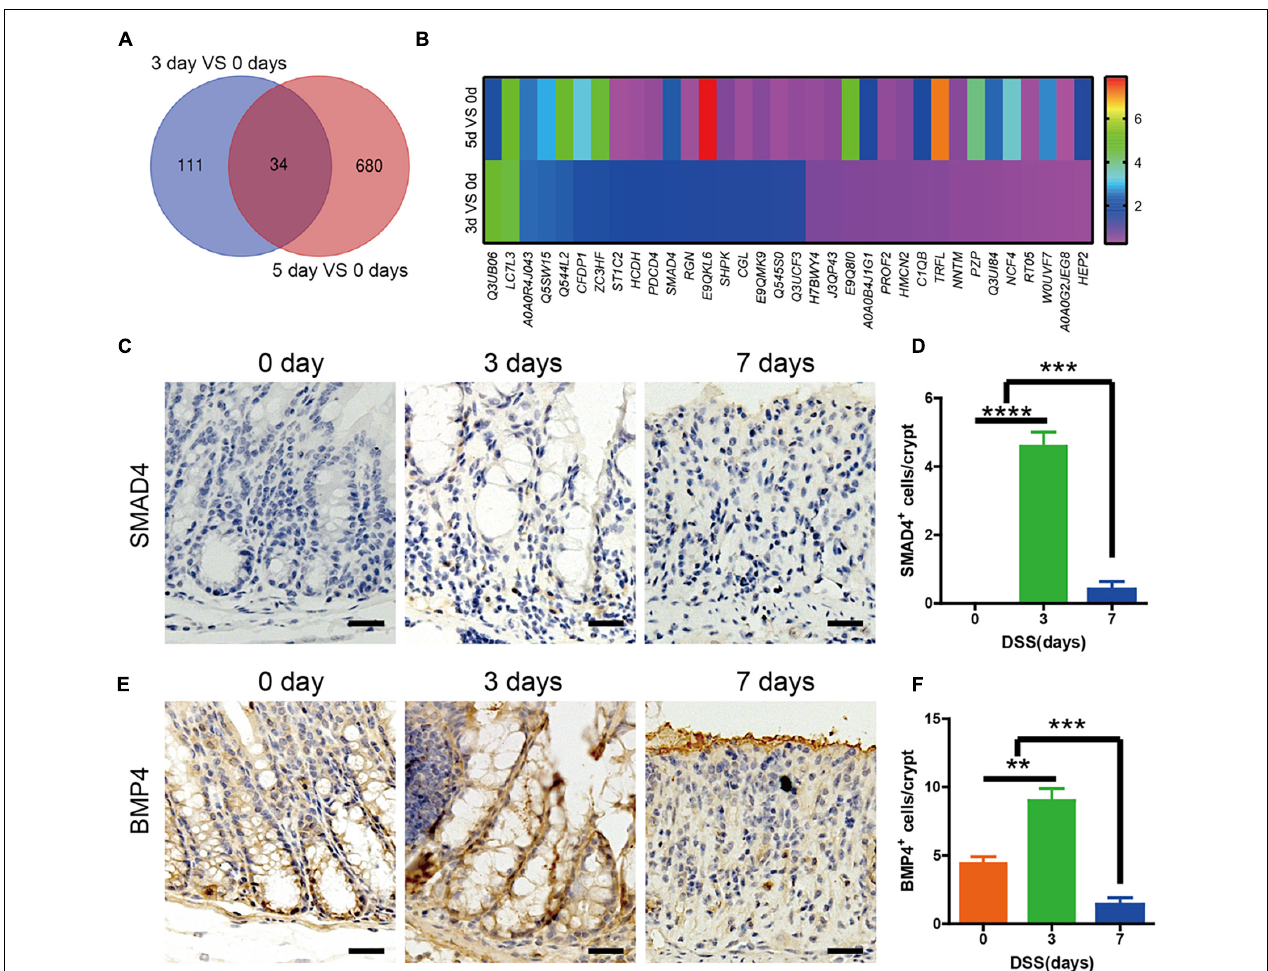
FIGURE 3 | SMAD4 and bone morphogenetic protein 4 (BMP4) expression in the colon of DSS-induced colitis mice. (A) Venn diagram showing the overlap colon protein between DSS-induced colitis on day 3 compared with day 0 and day 5 compared with day 0 ( n = 3). (B) Heatmap showing the expression levels of overlap colon protein between DSS-induced colitis on day 3 compared with day 0 and day 5 compared with day 0. (C) Immunohistochemistry staining of SMAD4 expression in DSS mice colon at days 0, 3, and 7. (D) Quantification of SMAD4-positive cells per crypt ( n = 5). (E) Immunohistochemistry staining of BMP4 expression in DSS mice colon at days 0, 3, and 7. (F) Quantification of BMP4-positive cells per crypt ( n = 5). Data represent mean ± SD with three independent experiments. One-way ANOVA and Bonferroni test for multiple testing was applied in all cases. ** p < 0.01, *** p < 0.001, **** p < 0.0001. Scale bar = 100 µ